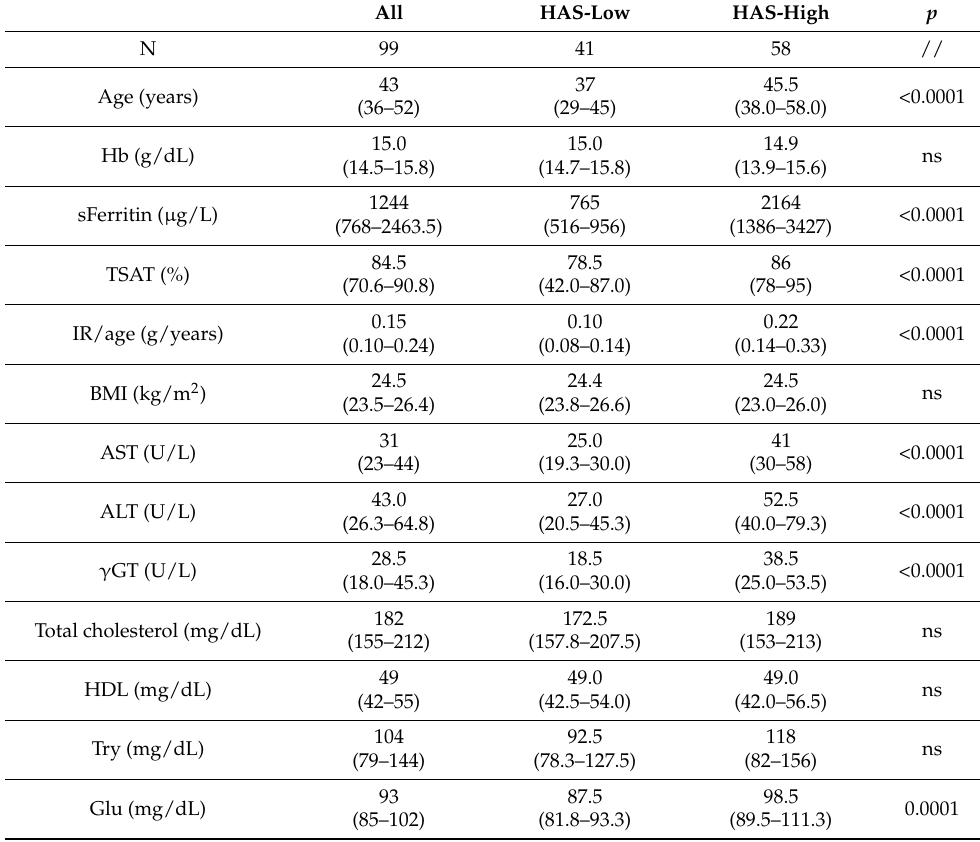
Table 1. Biochemical data of 99 patients divided according to the HAS-score. All HAS-Low